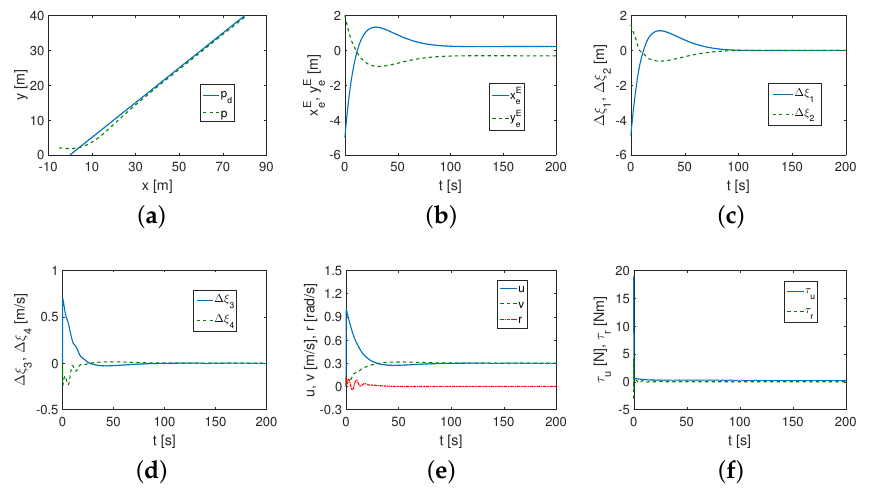
Figure 11. Simulation results for Kambara, CL controller and linear trajectory: ( a ) desired and realized trajectory; ( b ) position errors; ( c ) position error states; ( d ) velocity error states; ( e ) velocities; ( f ) applied force and